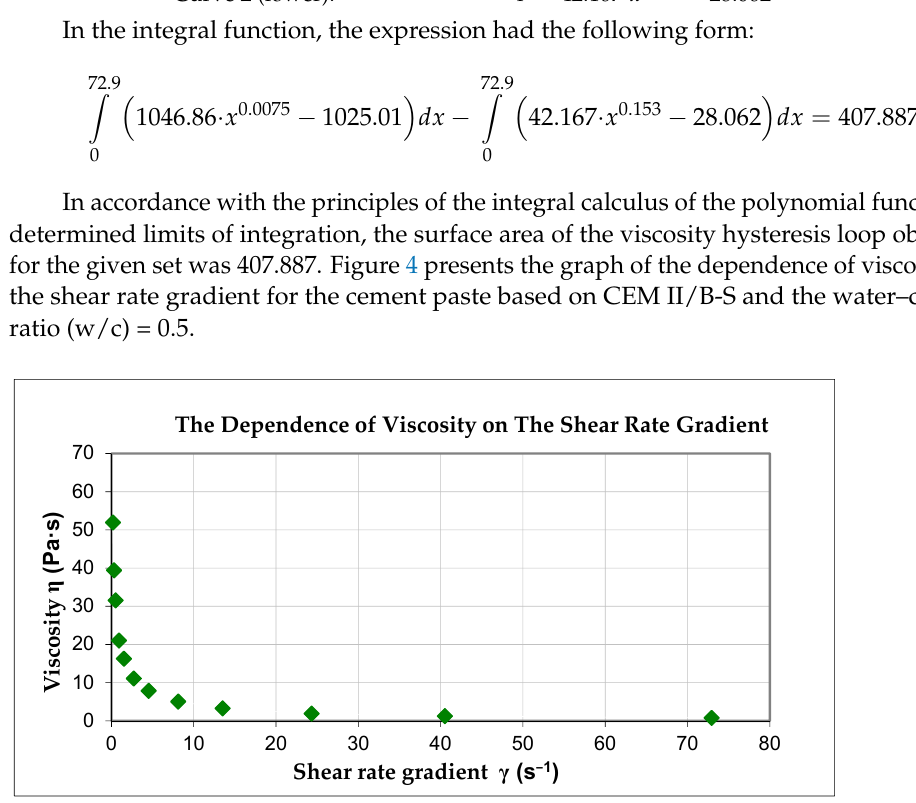
Figure 4. The dependence of viscosity on the shear rate gradient for the cement paste based on CEM II and the water–cement ratio (w/c) = 0.50.